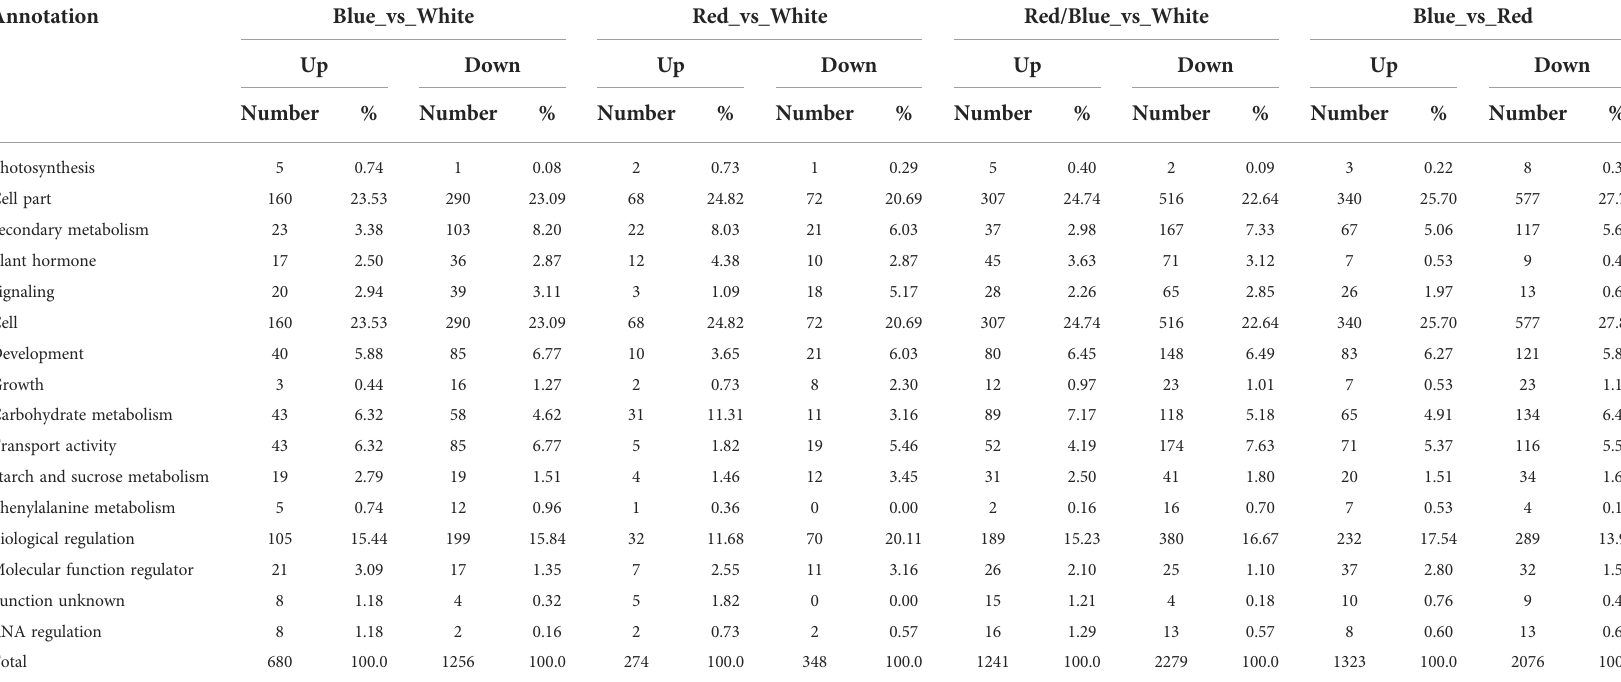
TABLE 1 Functional categories of the genes differentially expressed in the blue, red, and red/blue light when compared with white light and the comparison of blue vs. red in blueberry leaf. Annotation